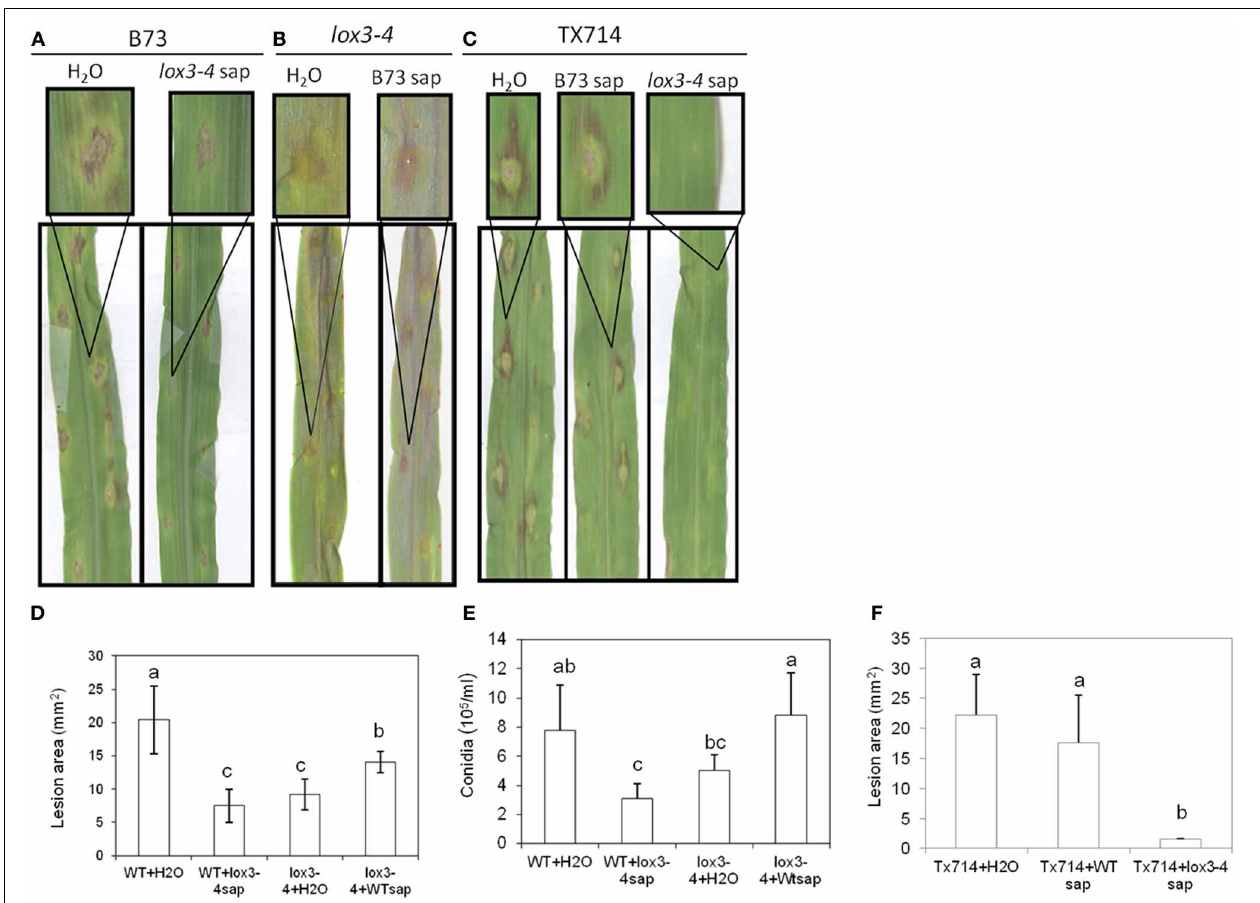
FIGURE 3 | Effect of xylem sap from lox3-4 mutant and B73 NIL plants on the pathogenicity of C. graminicola infected on the leaves. The xylem sap were collected from approximately 3-week-old lox3-4 mutant and B73 seedlings at 4 true leaf stage by cutting the stem from the position above the soil. Twenty microliter of sap per plant was injected into the wounding site on the stem of lox3-4 mutant and B73 or TX714 NIL, respectively, subsequently followed by the infection with C. graminicola at 1 × 10 6 spores/ml. The disease symptomswererecordedandphotographedat3dayspostinfectionon (A) B73 plantstreatedwithH2Oor lox3-4 xylemsap, (B) lox3-4 plantstreatedwithH2O